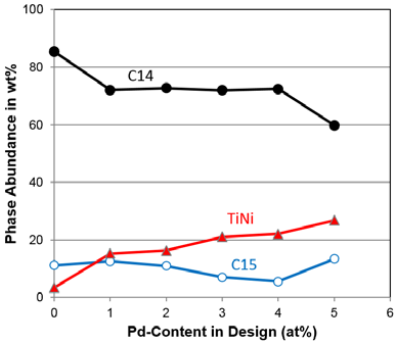
Figure 3. Evolution of the C14, C15, and TiNi phase abundances with increasing Pd-content in